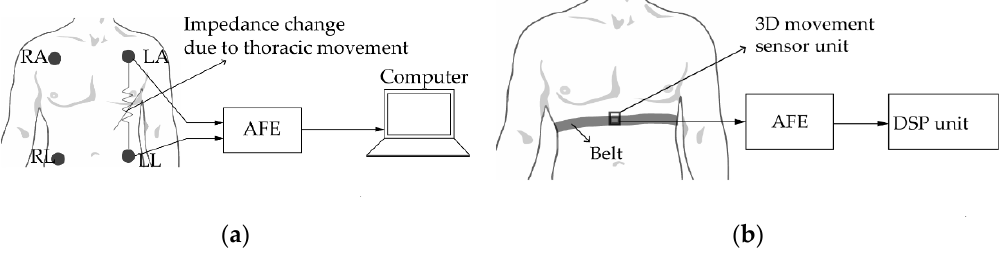
Figure 6. ( a ) Impedance pneumography setup; ( b ) 3D movement sensor setup for breath